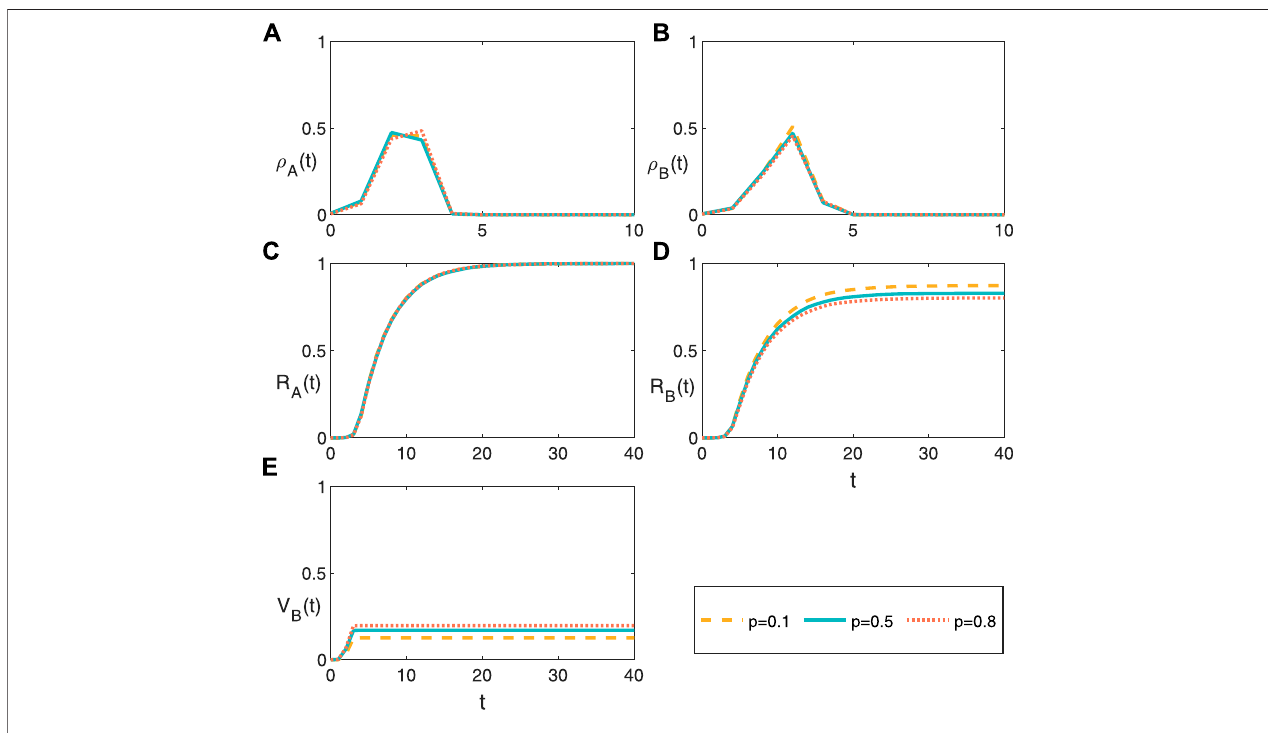
FIGURE 1 | (Color online) Temporal evolutions of the spreading dynamics. The density of nodes in the (A) informed state ρ A ( t ) of layer A , (B) infected state ρ B ( t ) of layer B , (C) removed state R A ( t ) of layer A , (D) removed state R B ( t ) of layer B , and (E) vaccination state R A ( t ) of layer (B) . We set the average degree of the two layers as 〈 k 〉 = 〈 k 〉 = 10, information spreading probability λ A B